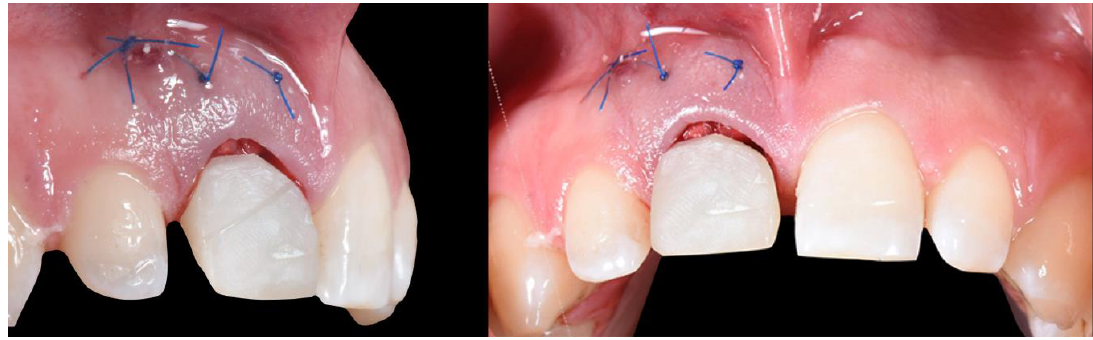
Figure 10. Different views of the available space between the marginal tissue and the provisional restoration.